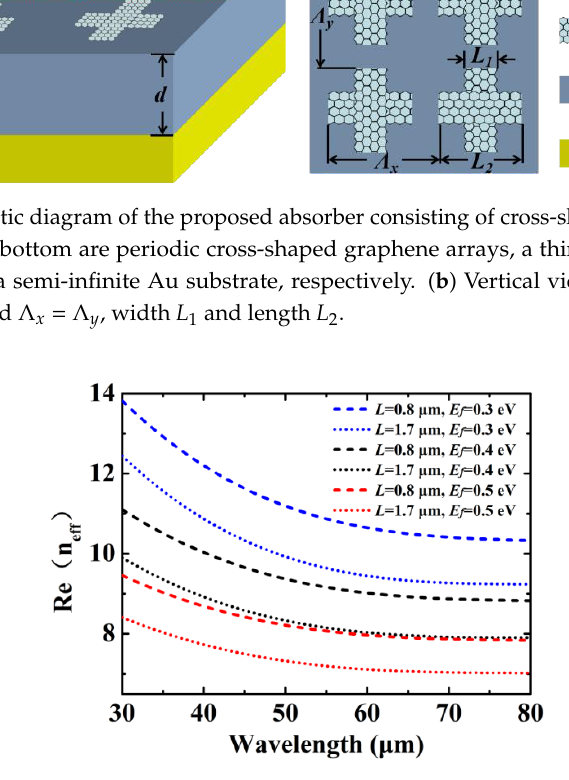
Figure 2. Real part of the effective refractive index Re( n eff ) of the GP vs. wavelength under different widths L and Fermi levels E f .